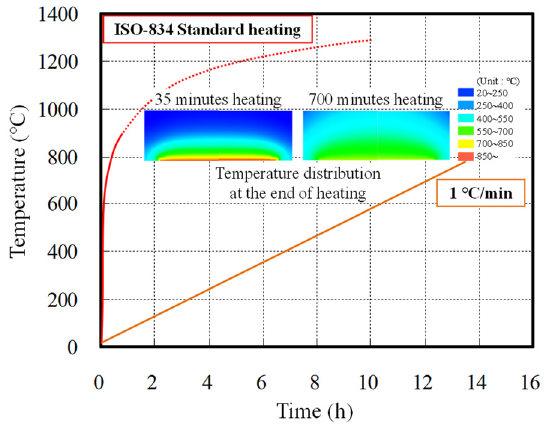
Figure 1. Temperature distribution of single-sided heated ring-restrained concrete according to heating rate.